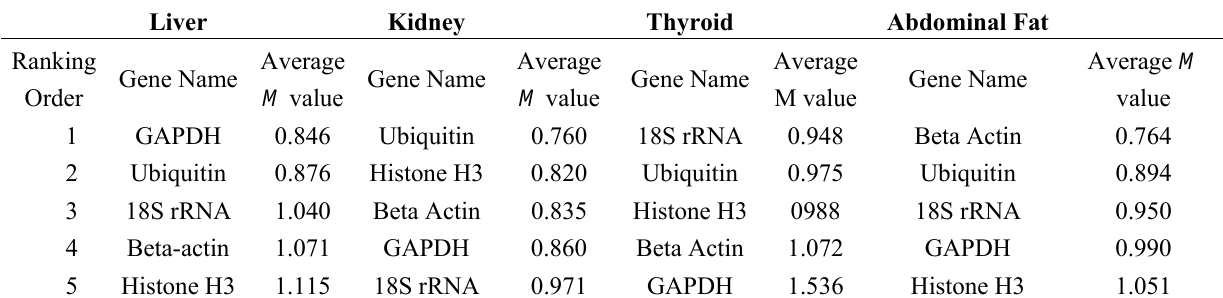
Table 1. Candidate reference genes according to the expression stability (calculated as the average M value after stepwise exclusion of worst scoring genes) by the geNorm VBA